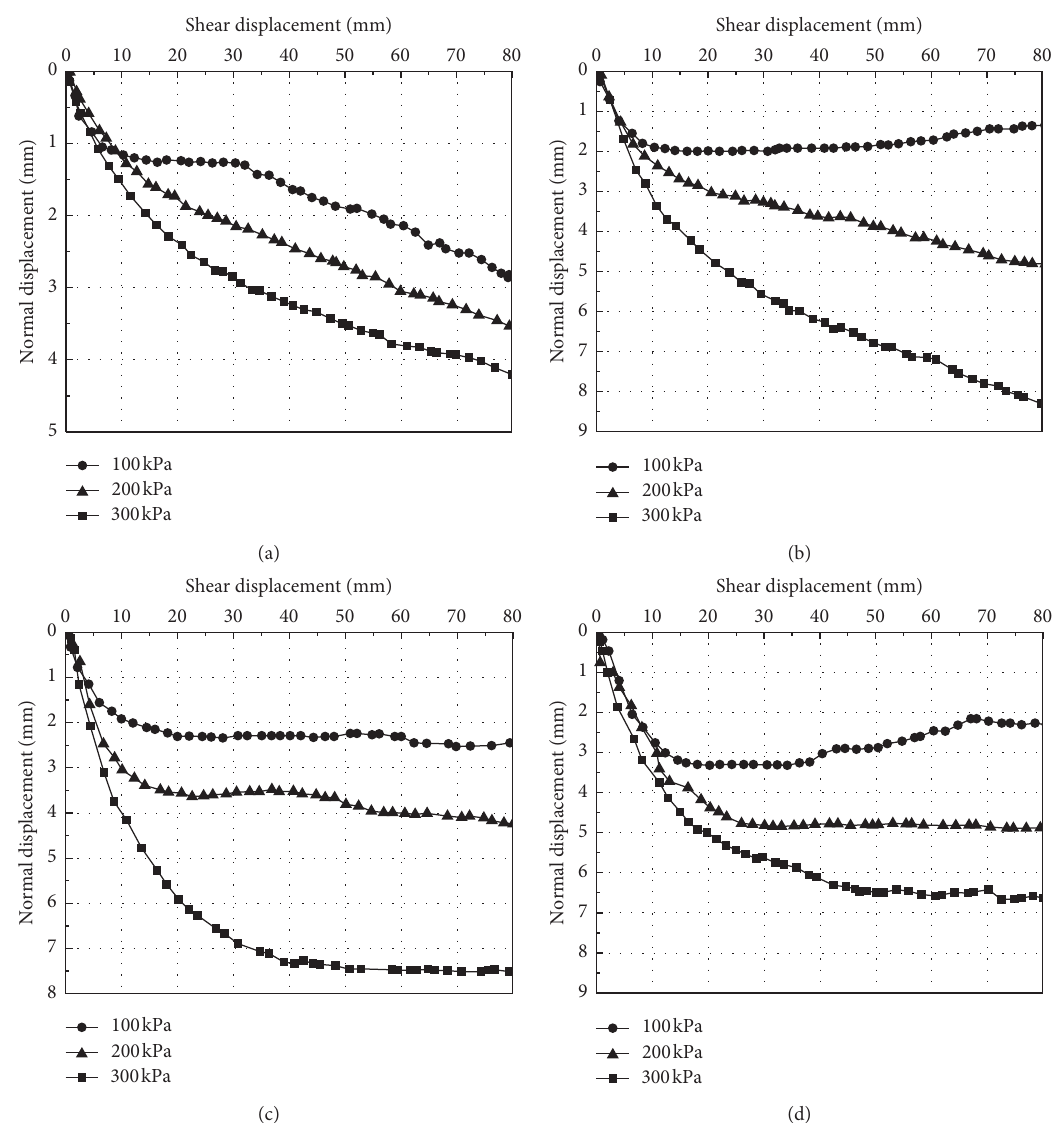
Figure 9: Normal displacement-shear displacement curve of sand and cobble soil with different CCs. (a) CC � 20%. (b) CC � 40%. (c) CC � 60%. (d) CC �